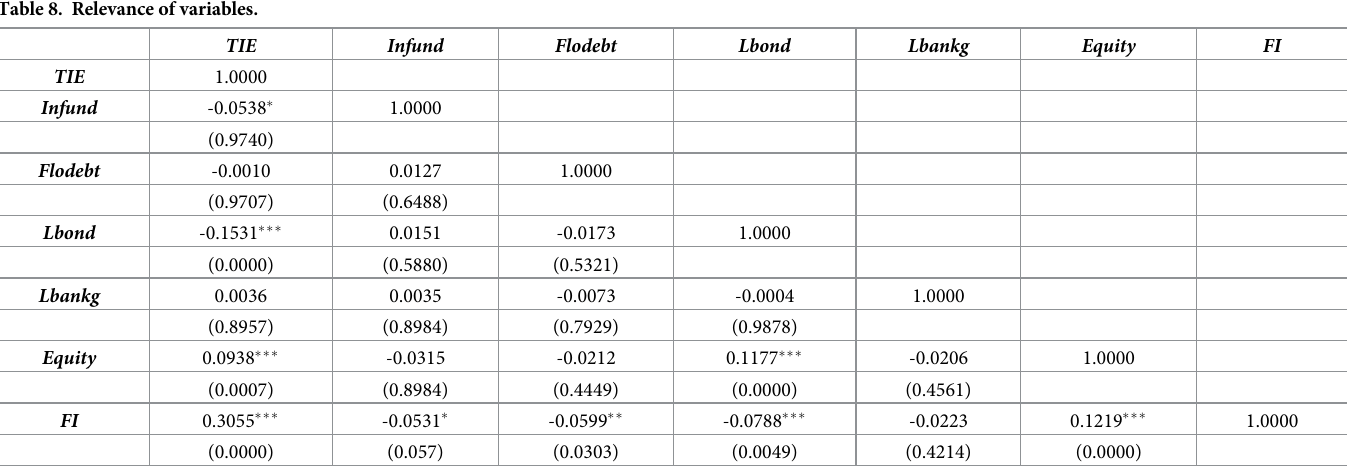
Table 8. Relevance of